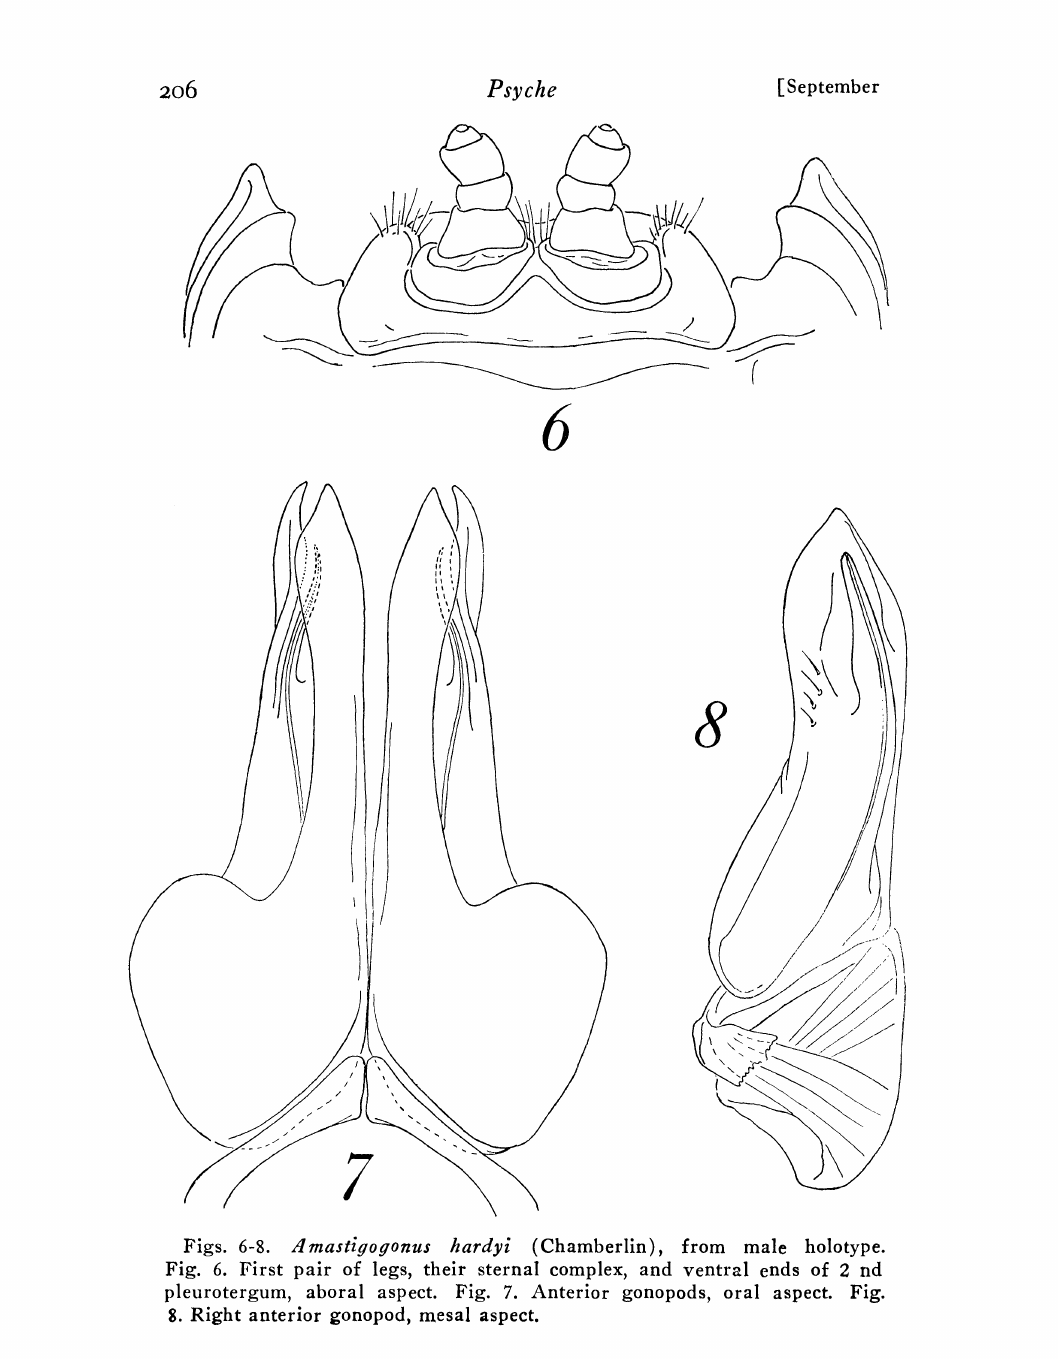
Figs. 6-8. zlmastigoyonus hardyi (Chamberlin), from male holotype. Fig. 6. First pair of legs, their sternal complex, and ventral ends of 2 nd pleurotergum, aboral aspect. Fig. 7. Anterior gonopods, oral aspect. Fig. $. Right anterior gonopod, mesal